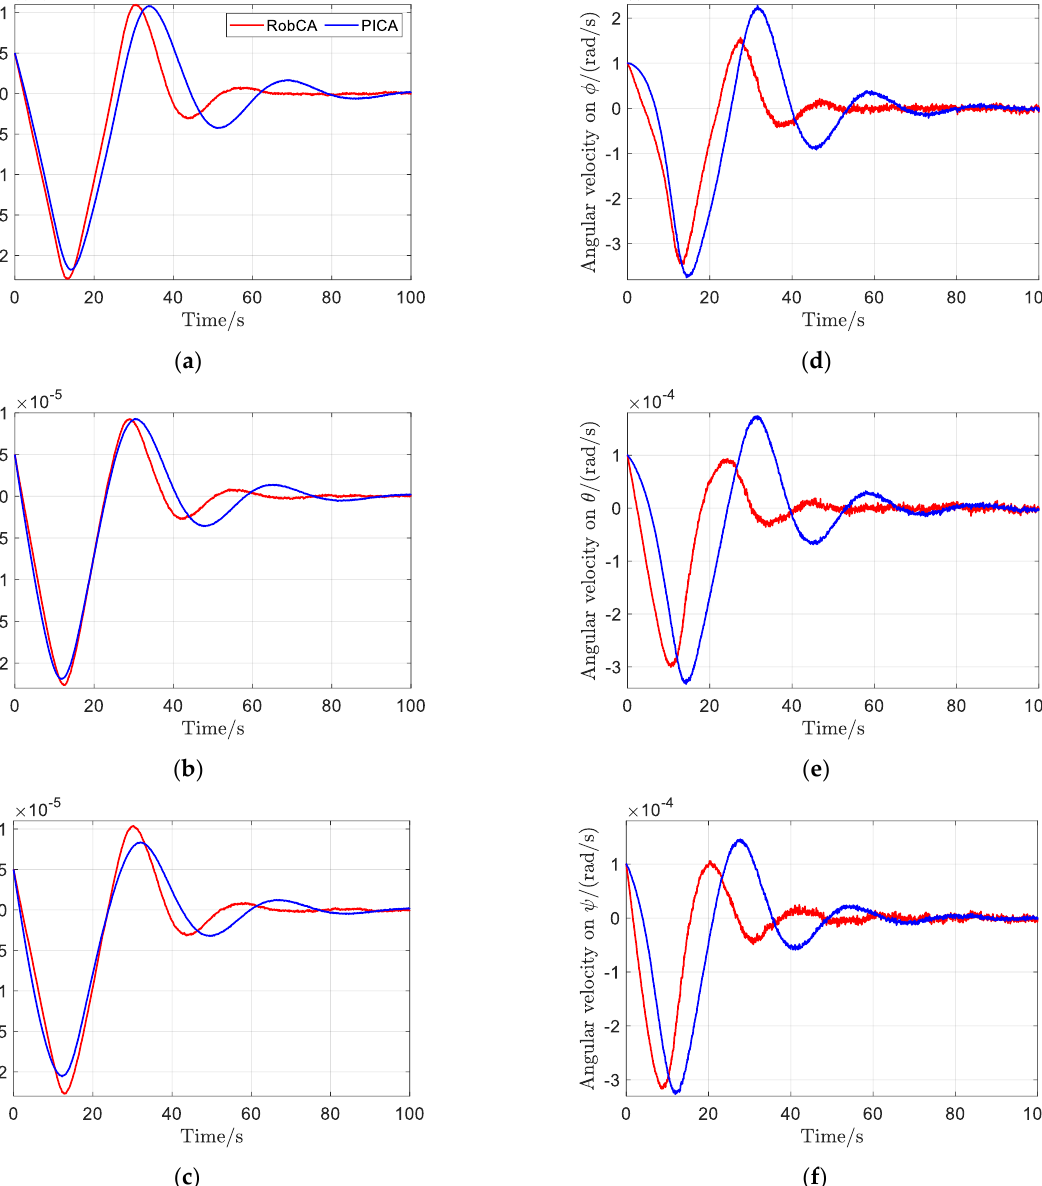
Figure 7. Time response comparisons of velocity and angular velocity of the test mass with the proposed RobCA method and the PICA method. ( a ) Velocity on x. ( b ) Velocity on y. ( c ) Velocity on z. ( d ) Angular velocity on ϕ . ( e ) Angular velocity on θ. ( f ) Angular velocity on ψ.